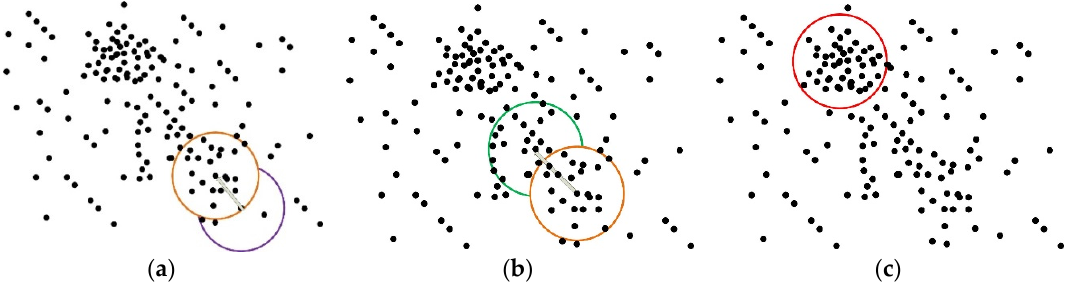
Figure 6. Steps for finding the highest density of color: ( a ) Search high color density; ( b ) search high color density again; ( c ) reach center of mass.